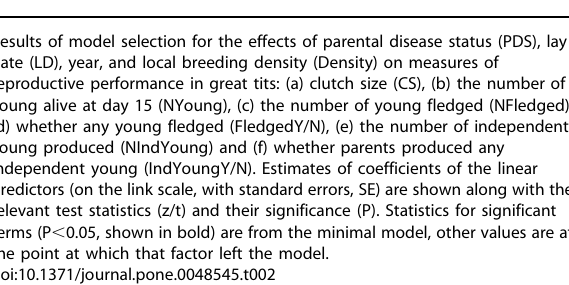
Table 2. The impacts of Paridae pox on reproductive performance of great